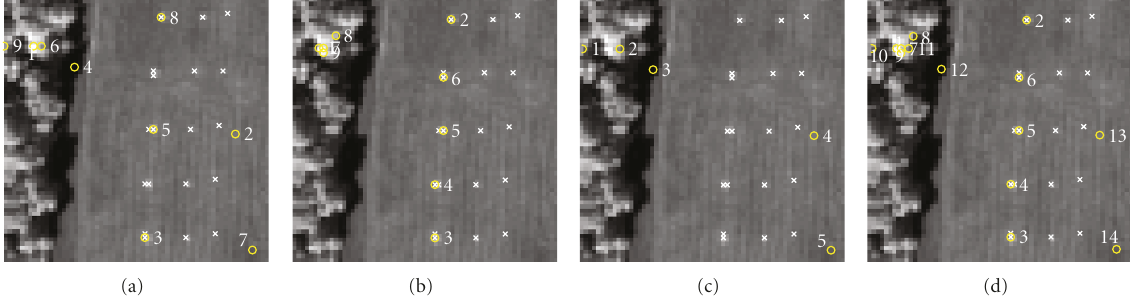
Figure 17: UNCLS-generated BKG and target pixels (a) 9 BKG pixels in original data; (b) 9 target pixels in sphered data; (c) 5 BKG pixels not identified as target pixels; (d) 14 pixels obtained by combining the pixels in (b)–(c).